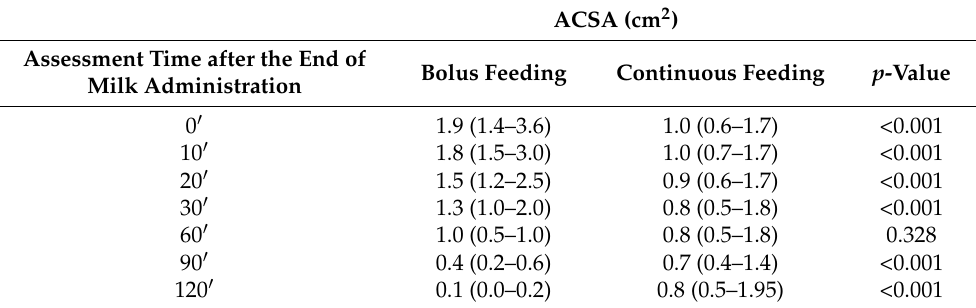
Table 2. Distribution of ACSA values (median/1st–3rd Quartile) according to feeding method (bolus vs. continuous) in the ultrasound (U/S) assessment time points with the corresponding p value.